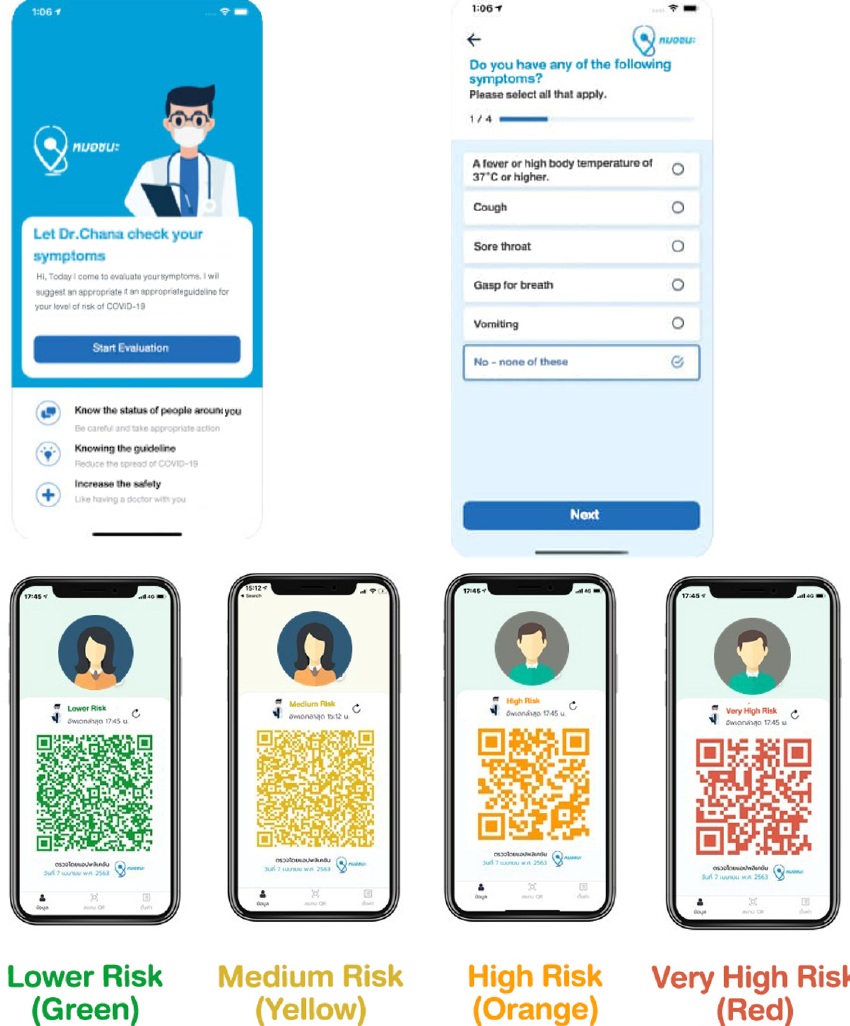
Figure 1. User interface of MorChana application.